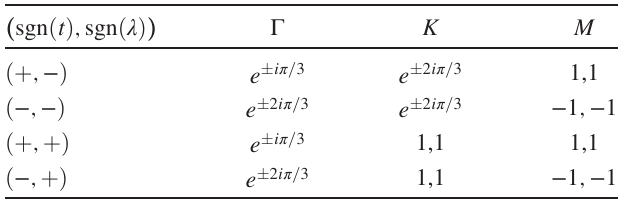
TABLE IV. Symmetry irreps at the high symmetry momenta for different signs of the model parameters t and λ